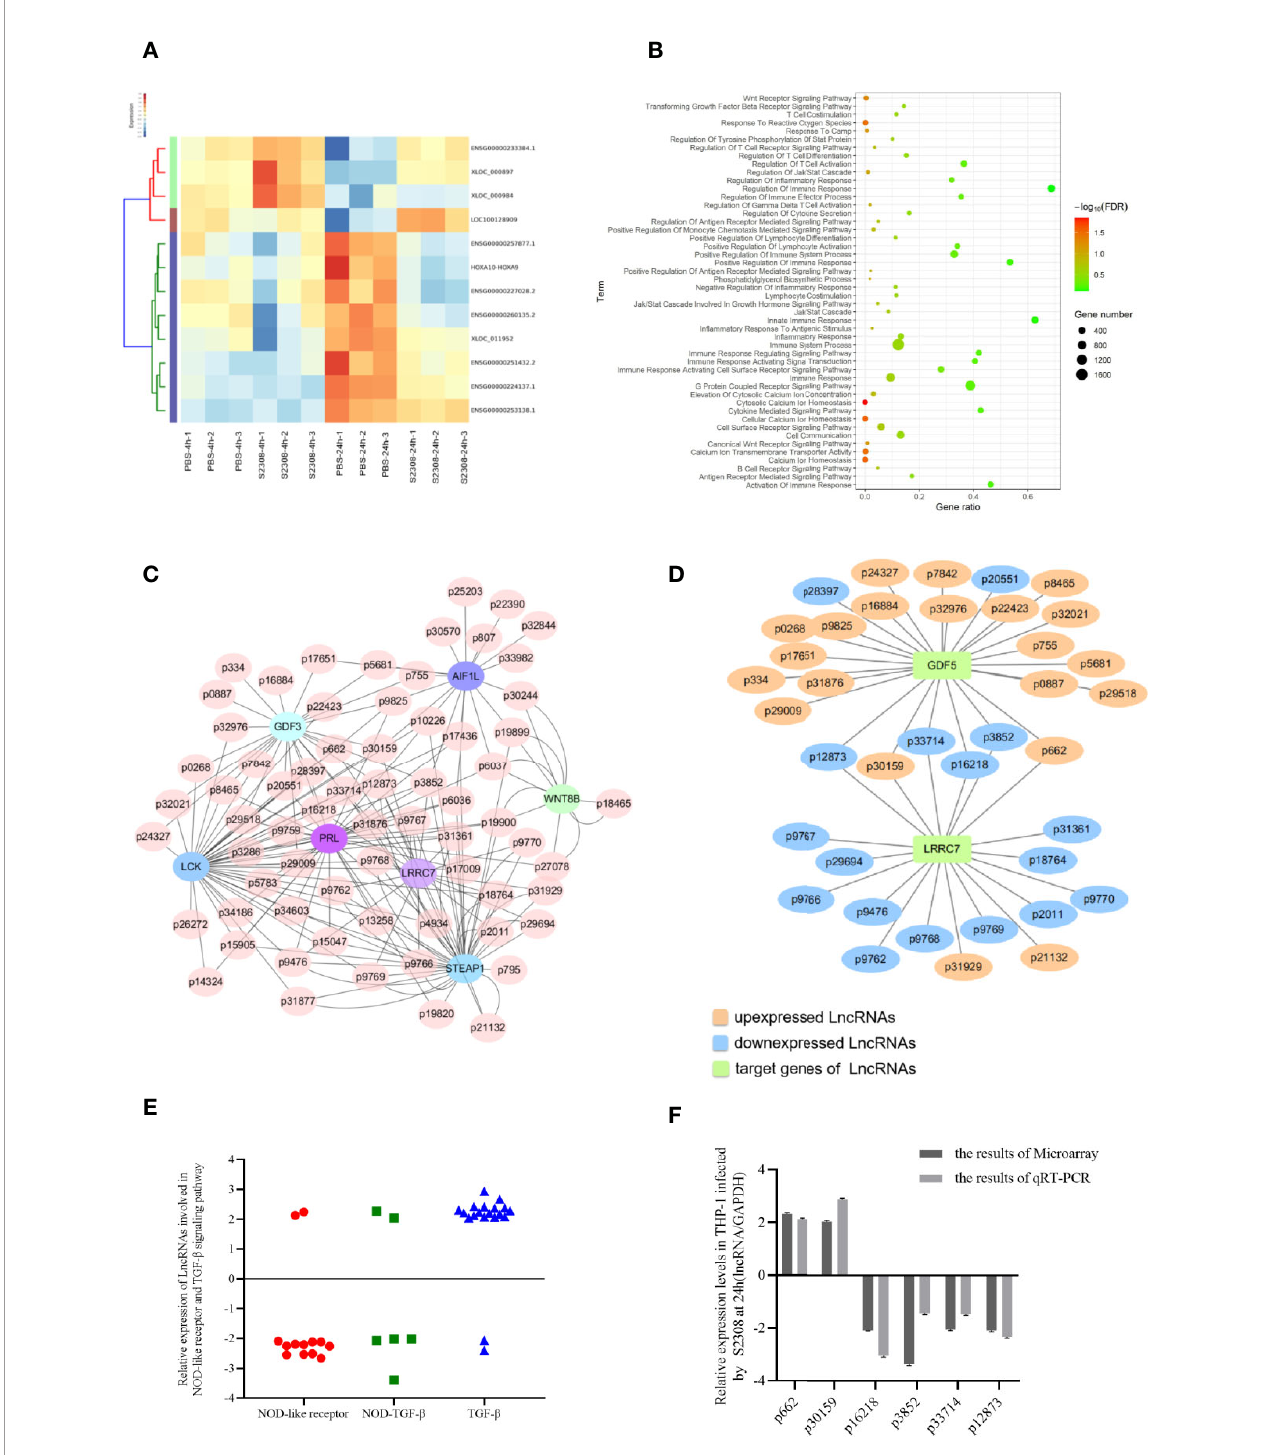
FIGURE 2 | Identi fi cation of differentially expressed lncRNAs involved in in fl ammatory responses in THP-1 cells infected by S2308. (A) Partial heatmap showing differentially expressed lncRNAs in THP-1 cells infected by S2308 at 4 and 24 h. (B) KEGG enrichment analysis for differentially expressed lncRNAs in THP- 1 cells infected by S2308 for 24 h. (C) Constructed lncRNA-mRNA correlation network according to the prediction of potential targets using co-expression analysis. (D) lncRNAs involved NOD-like receptor pathway and TGF- b signaling pathway. (E) Relative expression of the 42 lncRNAs involved in the NOD-like receptor pathway and TGF-beta signaling pathway in THP-1 cells infected by S2308 for 24 h. (F) Expression levels of the six lncRNAs involved in in fl ammation in THP-1 cells infected with S2308 for 24 h, as detected using qRT-PCR and microarray